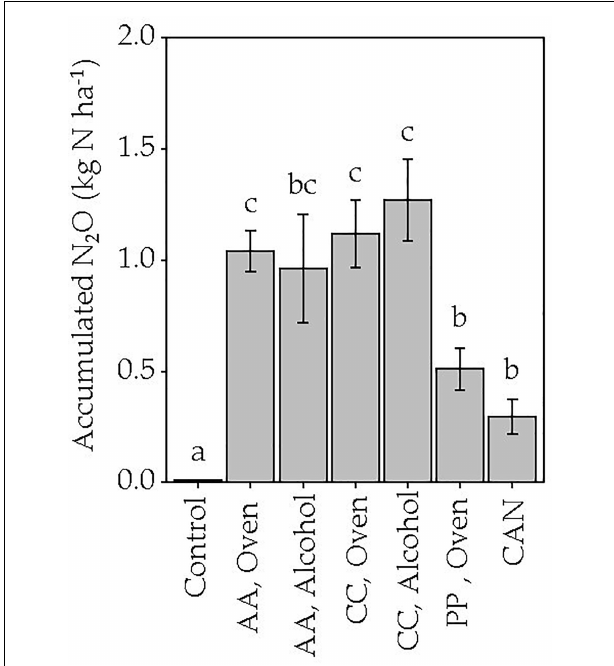
FIGURE 4 | Accumulated N 2 O-fluxes during the study period (56 days) after application of different jellyfish species [ A. aurita (AA), C. capillata (CC), P. periphylla (PP)] and pre-treatment (oven-dried and alcohol dried). No common lowercase letters indicated significant differences between the treatments ( p < 0.05).